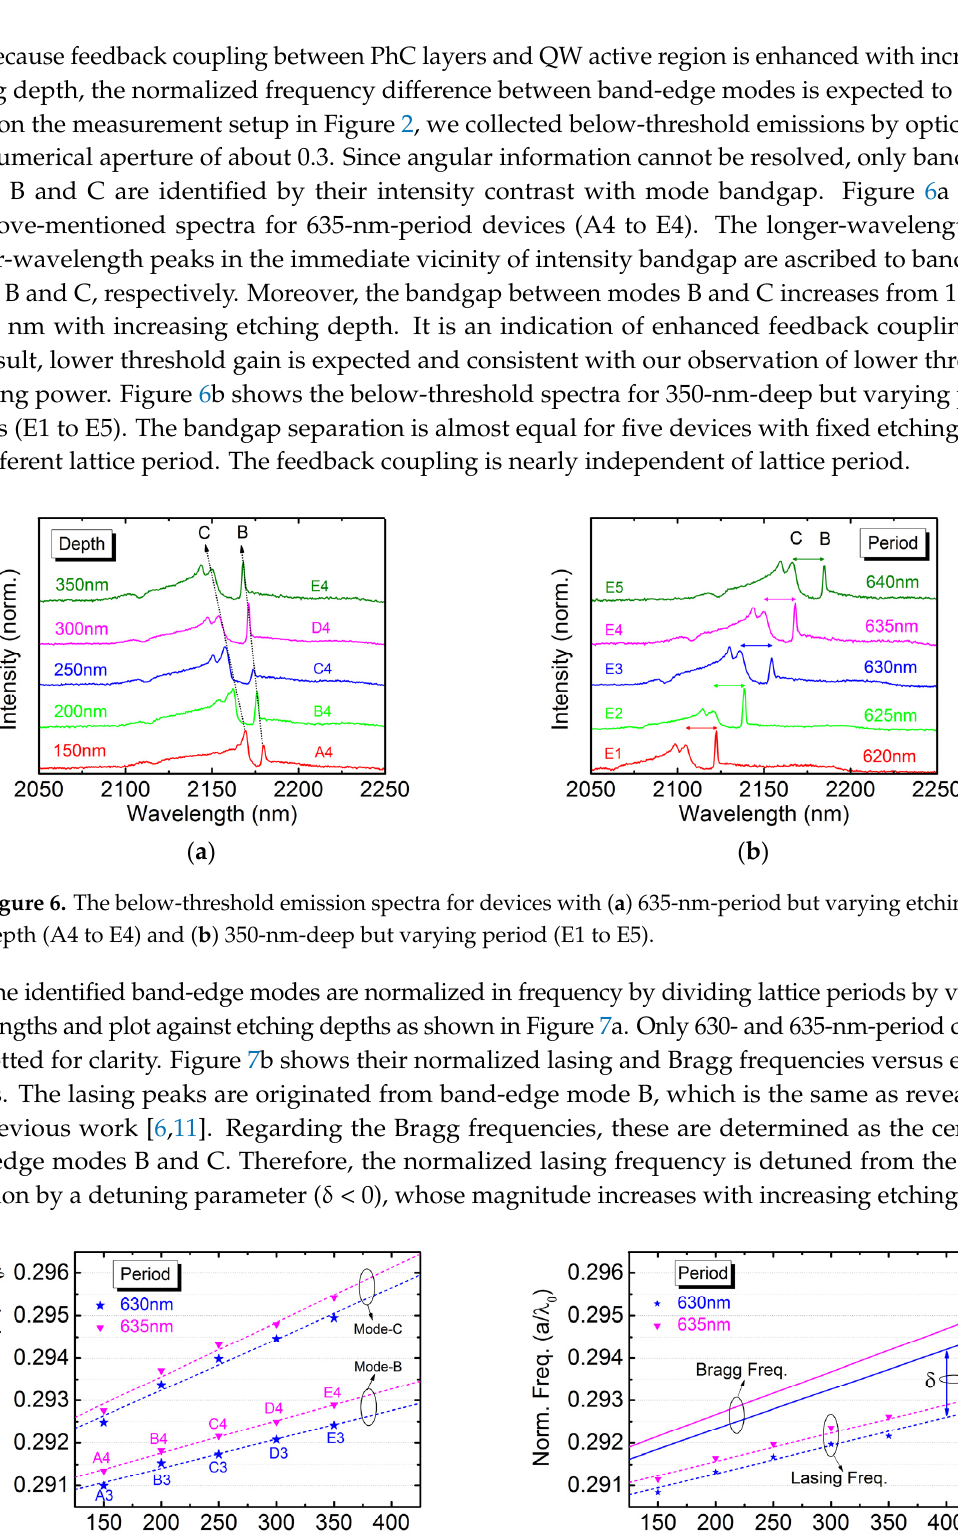
( b ) Figure 5. The dependence of threshold power density on the etching depth for ( a ) 620- and